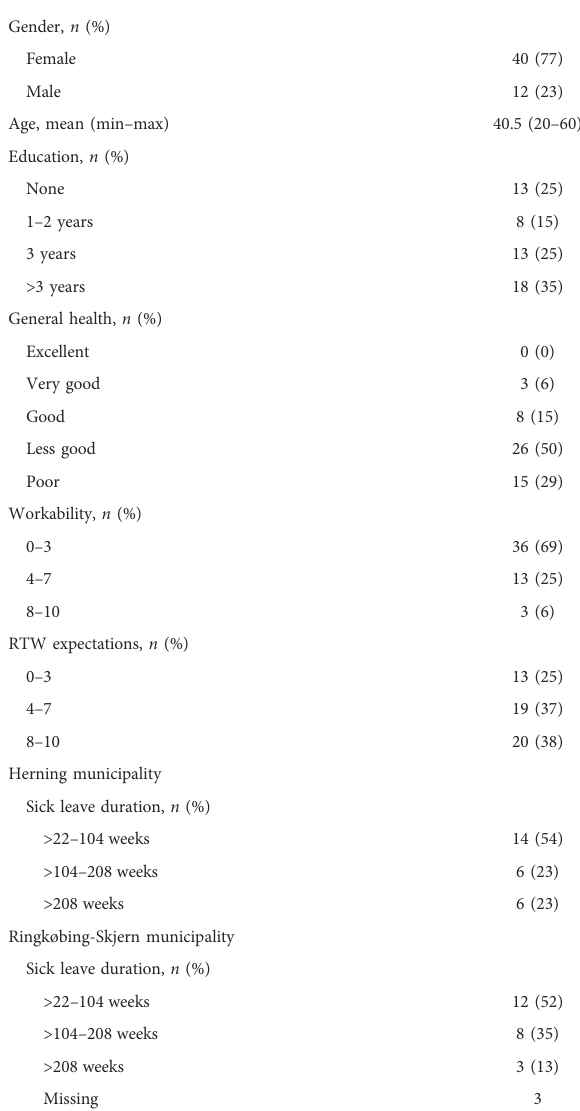
TABLE 1 Characteristics of the sick-listed individuals ( N =52) testing the